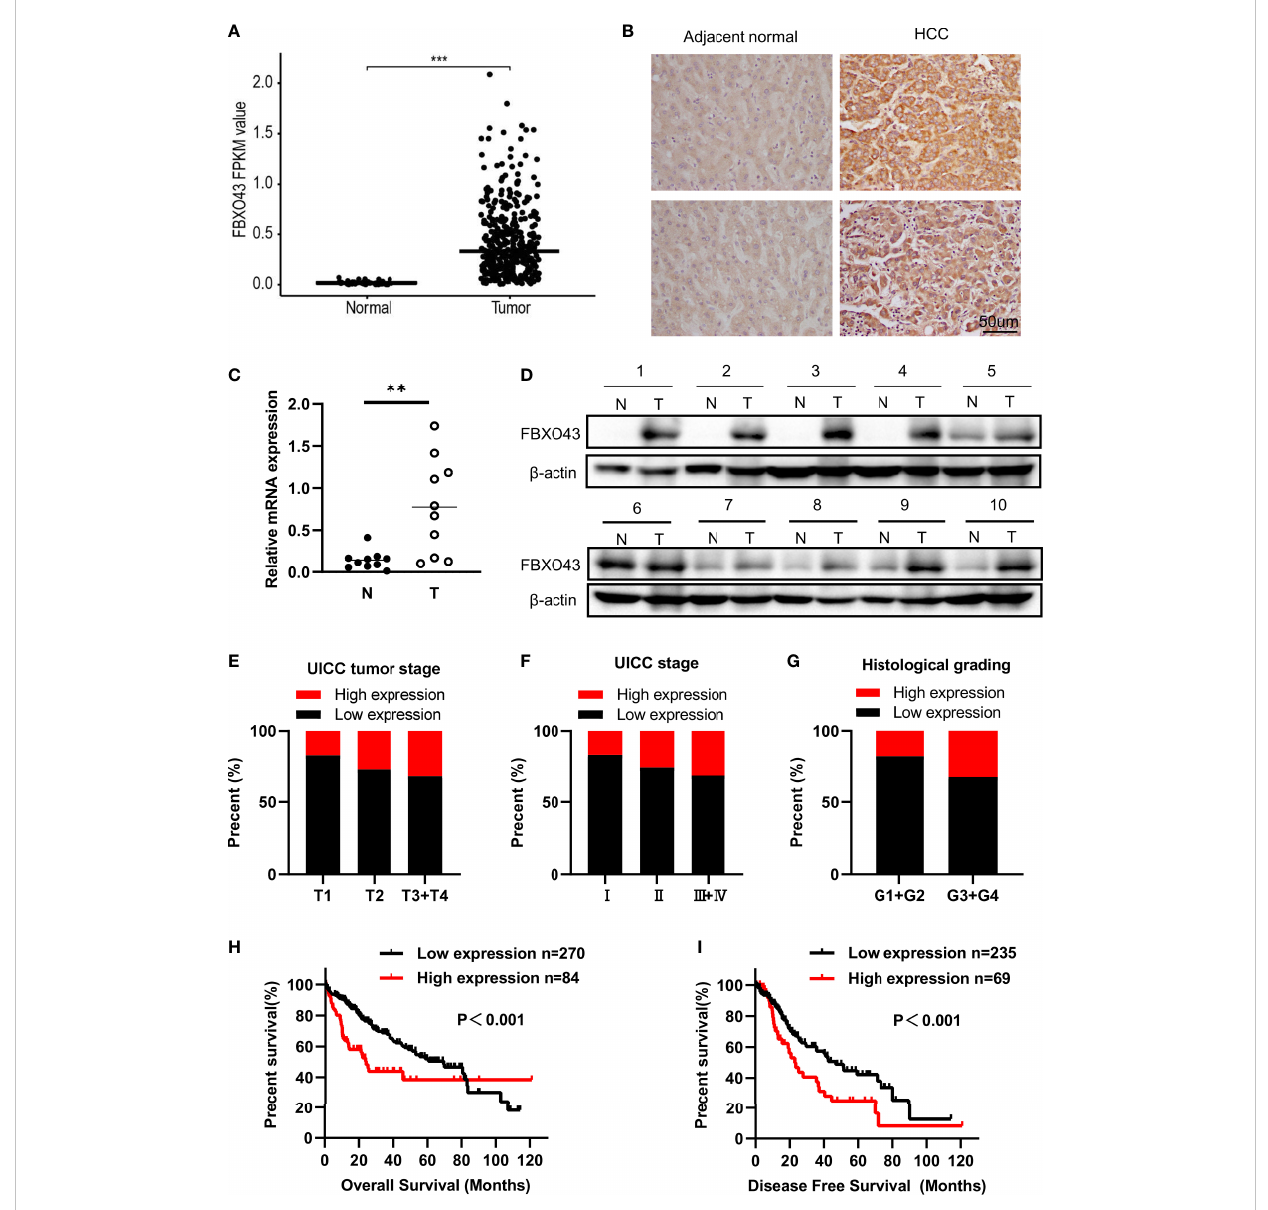
FIGURE 1 FBXO43 is highly expressed in HCC patients and positively correlated with poor survival. (A) The expression levels of FBXO43 in HCC (n=374) and adjacent normal tissues (n=50) in the TCGA database. (B) Immunohistochemical staining revealed that FBXO43 was upregulated in HCC tissues (n=20). (C) Quantitative real-time PCR (qRT − PCR) and (D) Western blot were used to measure the mRNA and protein expression of FBXO43 in 10 pairs of HCC tumor tissues (T) and adjacent normal tissues (N). (E – G) The association between FBXO43 and UICC tumor stage (E) , UICC stage (F) ,